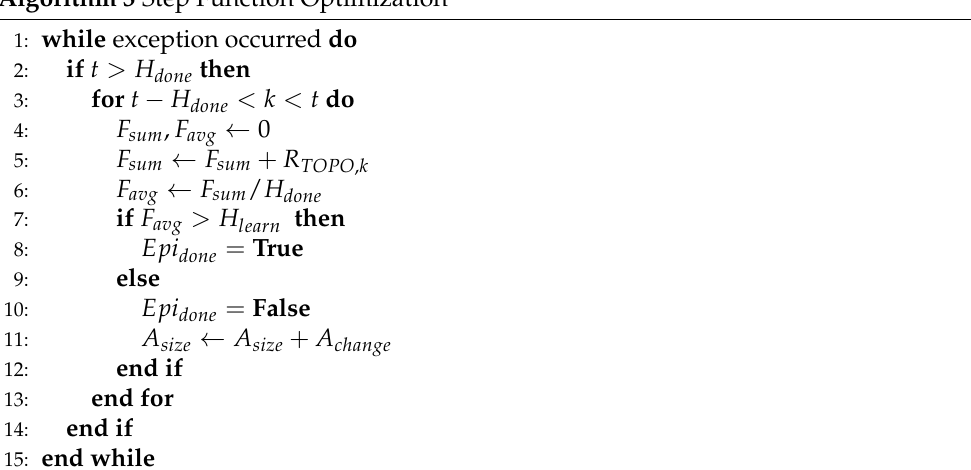
Algorithm 3 Step Function